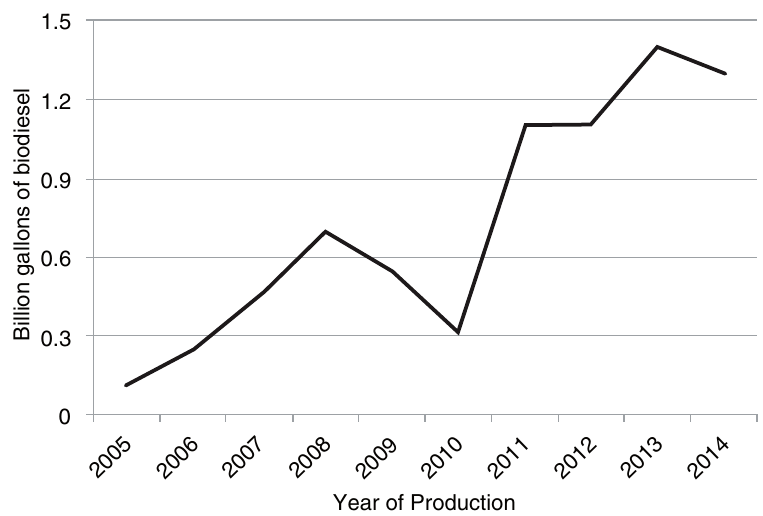
Figure 2. Biodiesel production volumes from all source oils over the last 9 years in the USA. Production has increased from 112 million gallons in 2005 to over 1.3 billion gallons in 2014. A large dip in production was seen from 2008 to 2010 during the economic